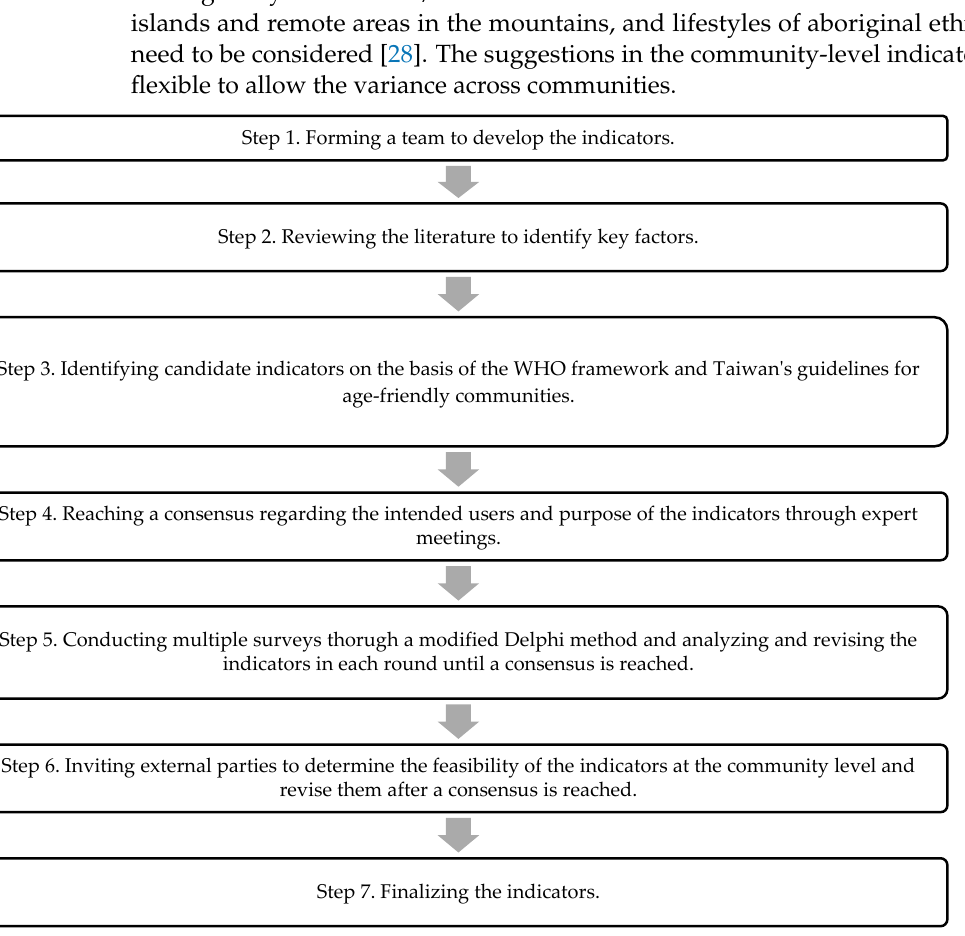
Figure 1. Process of developing the indicators